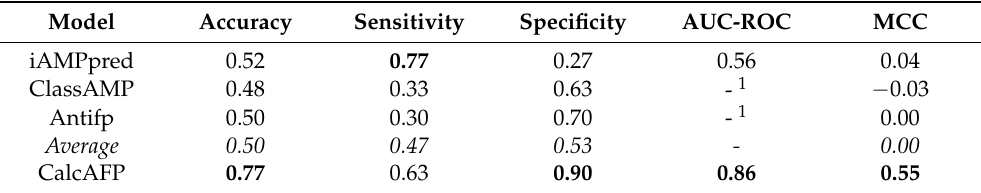
Table 3. Comparison of different AFP prediction classifiers using the external data set. Bold values indicate the best value per